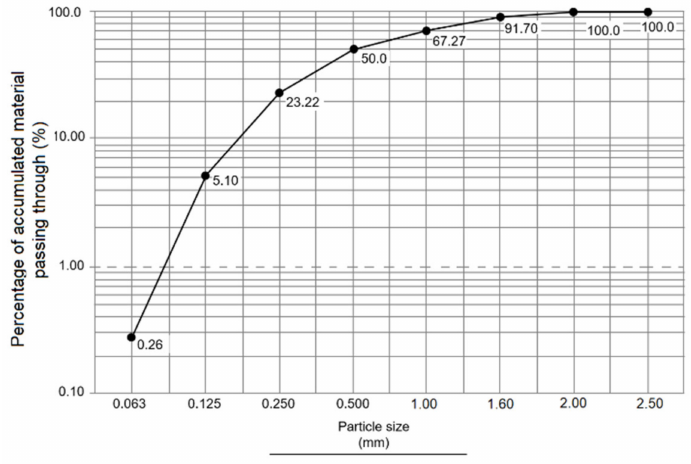
Figure 8. Standard sand granulometric